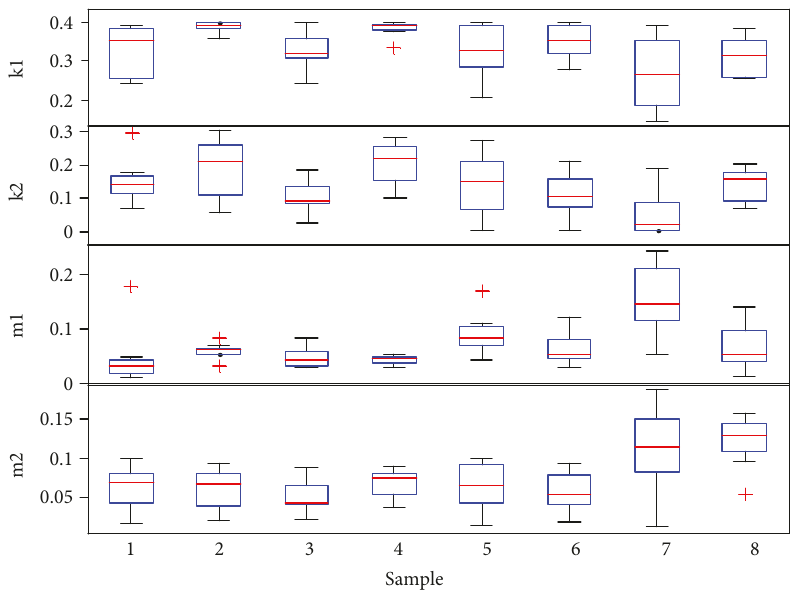
Figure 13: Statistical distribution of normal (1 – 4) and paralyzed samples (5 – 8).